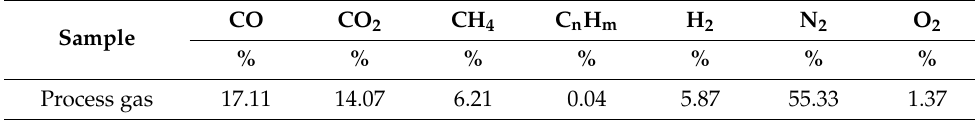
Table 4. Results of the analysis of the process gas